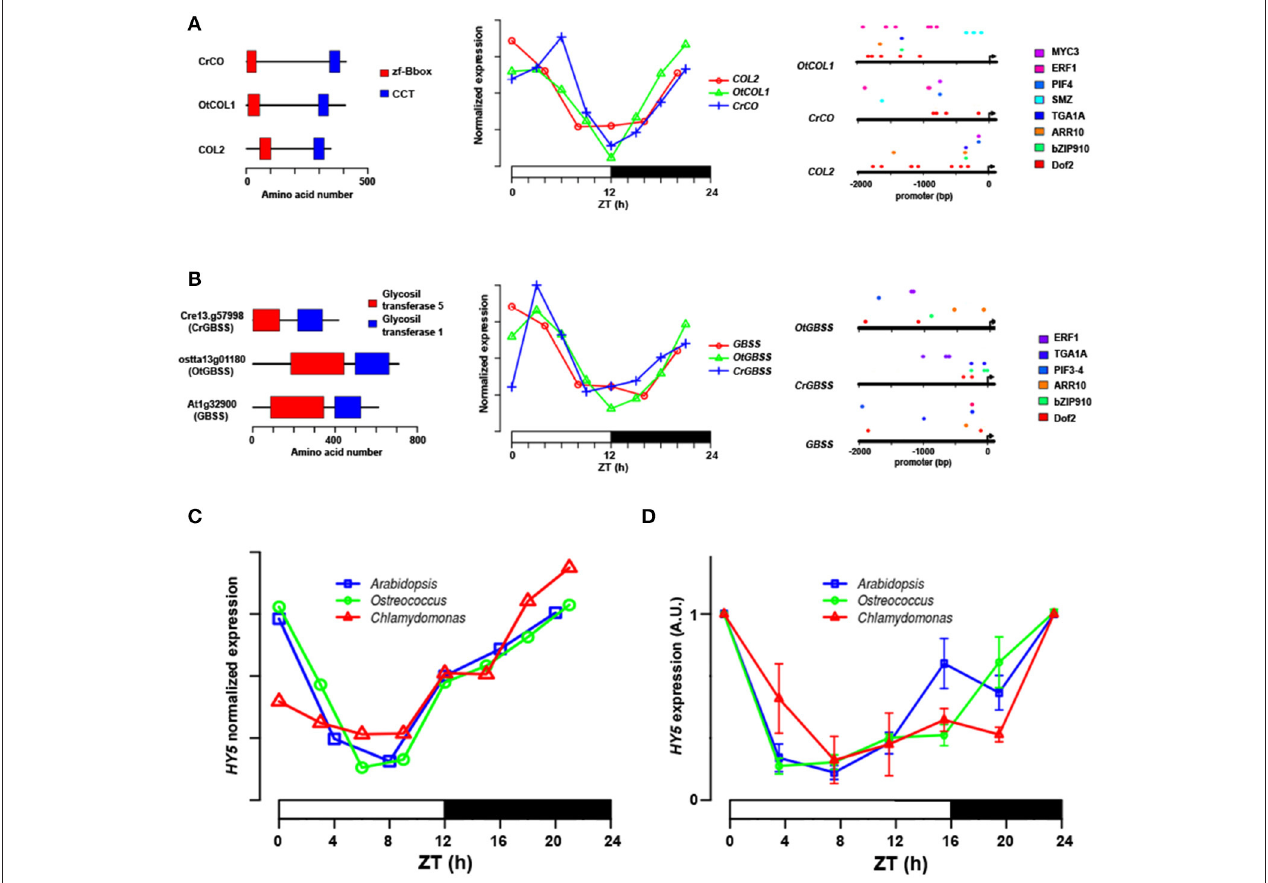
FIGURE 11 | Putative TF orthologues show a conserved protein domain structure, promoter distribution and circadian expression profile in algae and higher plants. (A) Gene structure (leftmost), expression in 24h ND course (middle) and TF binding site in the promoter of Arabidopsis COL2 gene and putative orthologues from the two microalgae. (B) As above, showing Arabidopsis GBSS gene and putative orthologues. (C) Normalized expression level in 24h ND photoperiod from the microarray and RNAseq experiments of HY5 gene from Arabidopsis (blue), CrHY5 from Chlamydomonas (red) and OtHY5 from Ostreococcus (green). Notice the high similarity in the expression profile of the three species. (D) Expression levels (Arbitrary Units) of HY5 (blue) from Arabidopsis , CrHY5 from Chlamydomonas (red), and OtHY5 from Ostreococcus (green) in a 24h course in LD by QPCR. Notice how HY5 circadian expression pattern is also conserved in the three species, although the daily expression lengthens, strongly supporting the idea that they are true orthologues. Time is shown in hours (h) as Zeitgeber Time (ZT). For each time point of the analysis, three biological replicates and three technical replicates were analyzed. Each point shows standard error bars ±